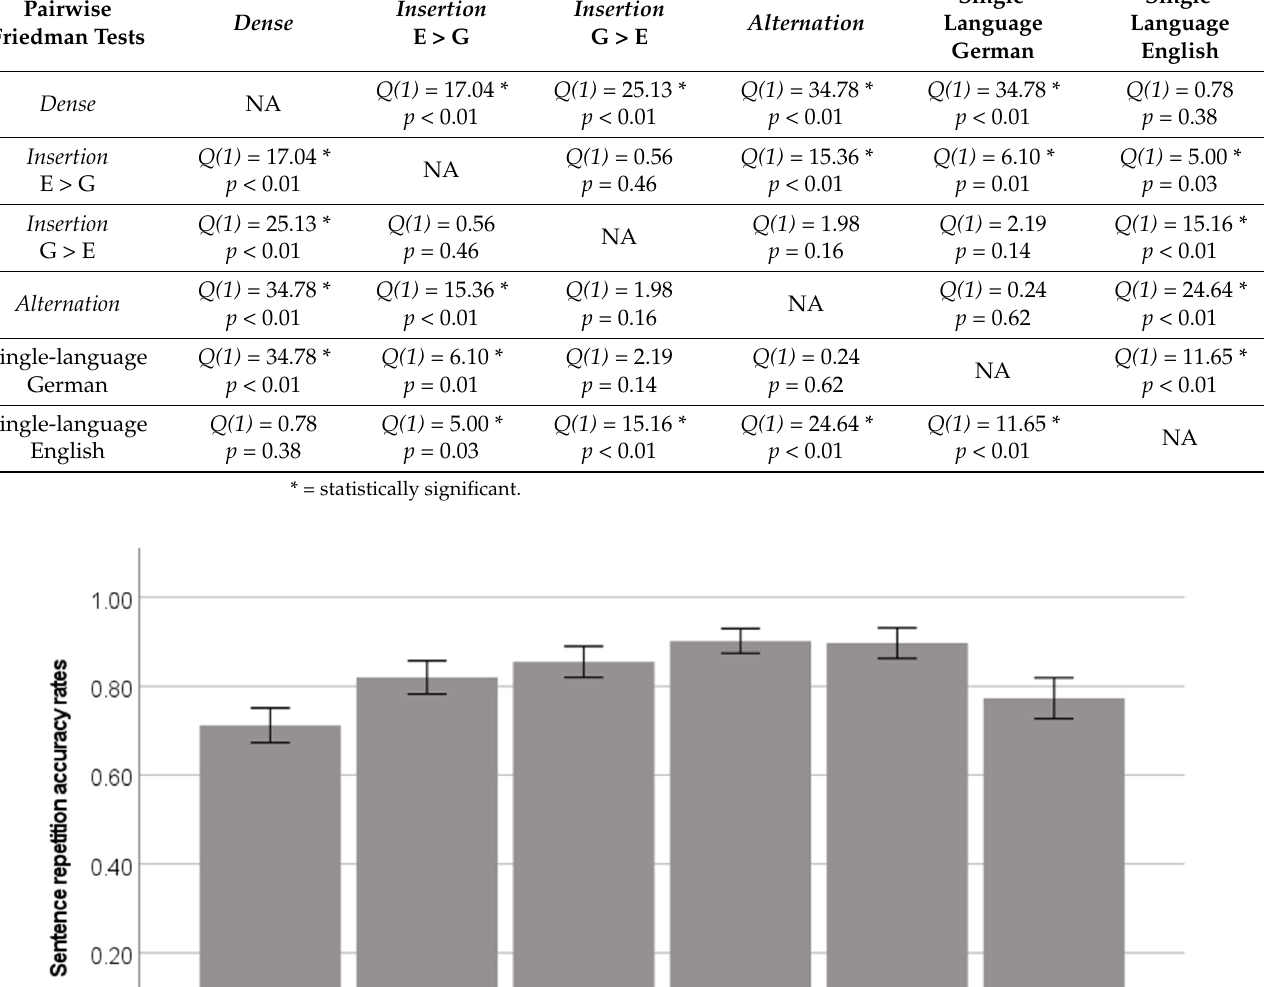
Table 2. Pairwise comparisons sentence repetition task.